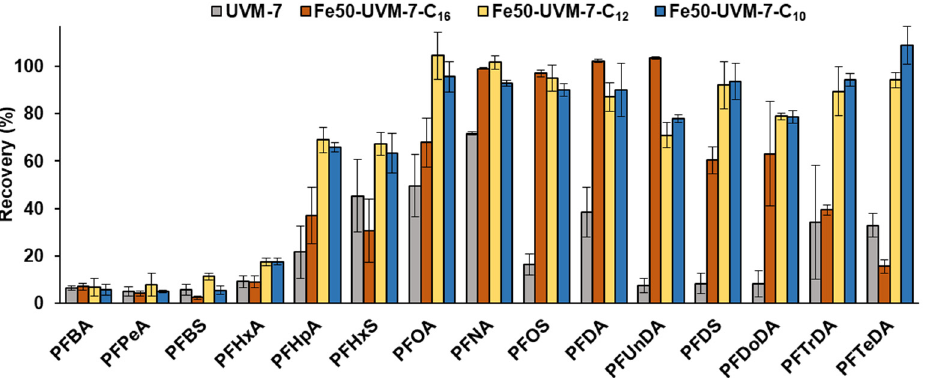
Figure 4. Effect of the sorbent (presence of Fe and pore size) on the recovery of PFASs. Conditions: 150 mg of sorbent, 10 mL of spiked ultrapure water (1 μ g L − 1 ), elution of 2 mL of